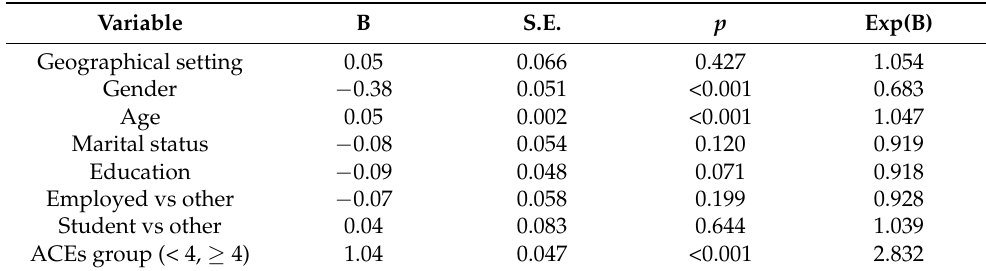
Table 3. Relationship between ACEs and chronic